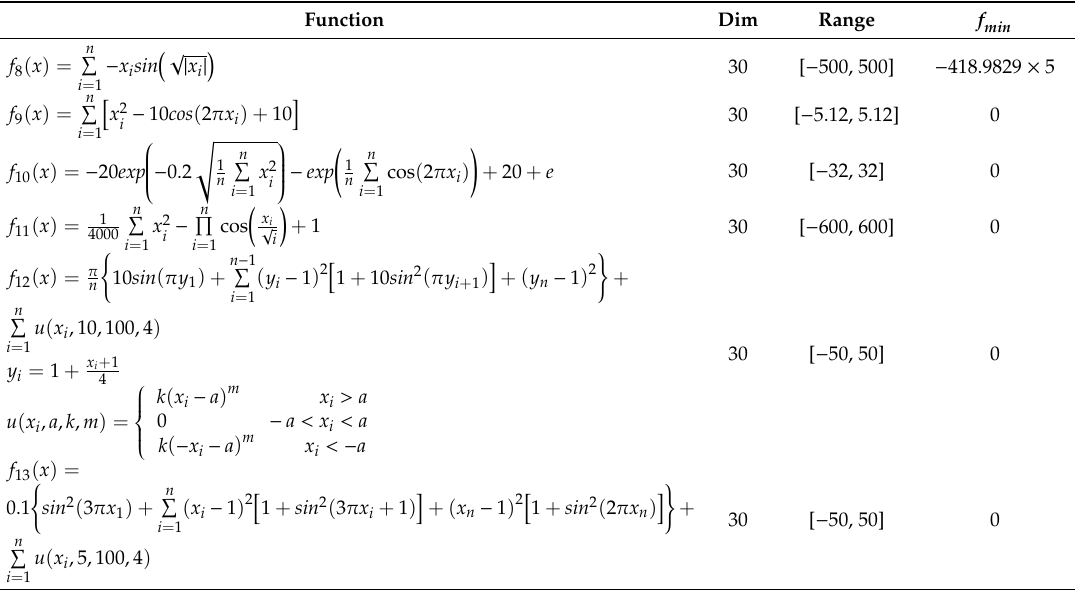
Table 3. Multimodal benchmark